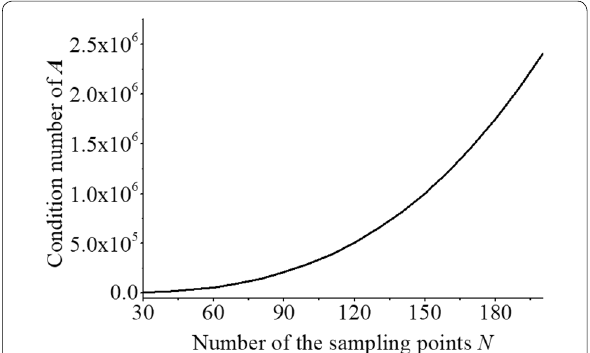
Figure 2 Variation of the condition number of the coefficient matrix A with the number of sampling points